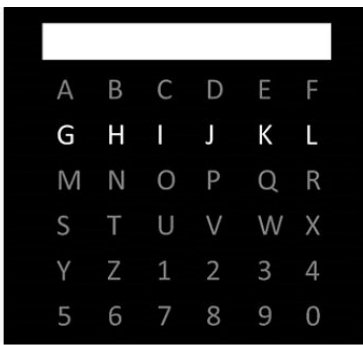
Figure 8. Classical P300 spelling paradigm described by Farwell–Donchin (1988).